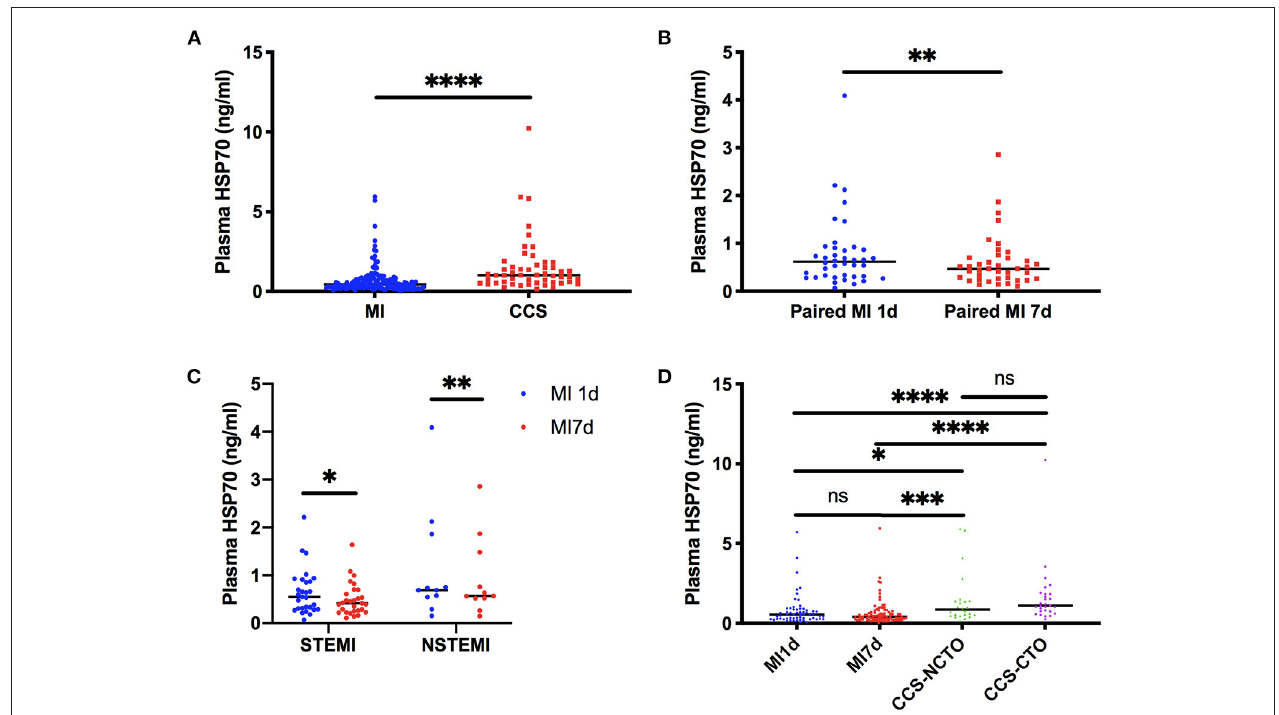
FIGURE 1 | Detailed comparison of plasma HSP70. (A) Comparison between overall patients with MI and CCS. (B) Matched-pairs comparison between day 1 and day 7 post-MI. (C) Matched-pairs comparison between day 1 and day 7 in STEMI and NSTEMI. (D) Comparison among patients with day 1 and day 7 post-MI, CCS with no CTO, and CCS with CTO lesions. * P < 0.05, ** P < 0.01, *** P < 0.001, **** P < 0.0001. ns, not significant; MI, myocardial infarction; MI1d, 1 day post-MI; MI7d, 7 days post-MI; STEMI, ST-segment elevation myocardial infarction; NSTEMI, non-ST-segment elevation myocardial infarction; CCS, chronic coronary syndrome; CTO, chronic total occlusion; NCTO, no chronic total